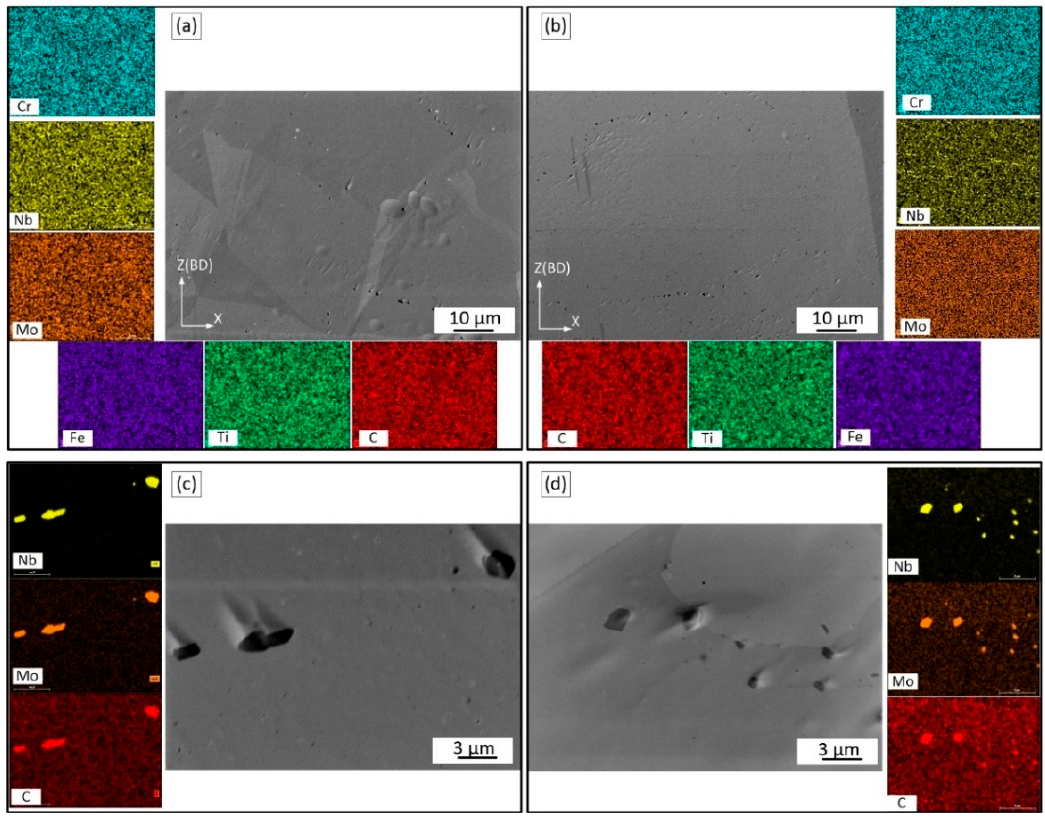
Figure 5. Precipitation after the ST in ( a,c ) Alloy 1 and ( b,d ) Alloy 2, with their respective Nb and Mo elemental maps.